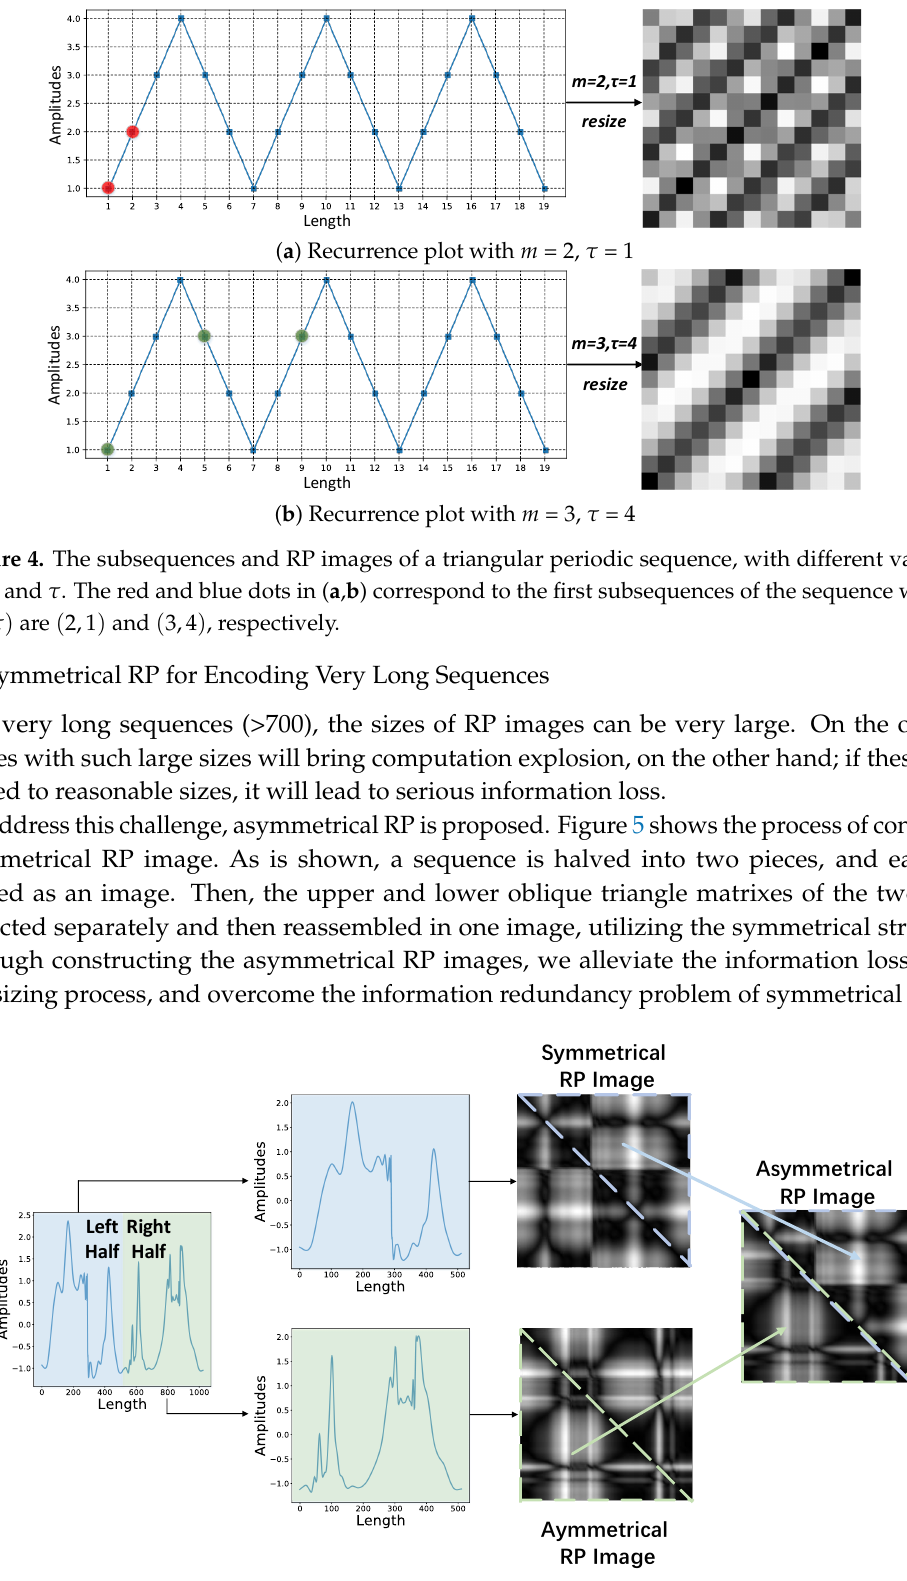
Figure 5. TheillustrationofconstructinganasymmetricalRPimage(thesequencecomesfrom ‘Mallat’